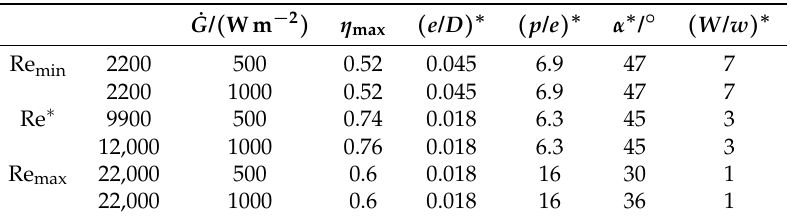
Table 6. Maximum efficiency and optimum roughness parameters according to the model developed by Singh et al. [43]. ˙ G / ( Wm − 2